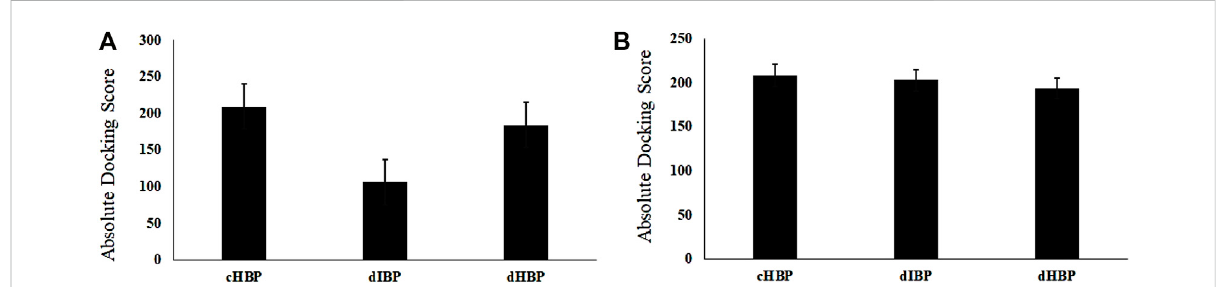
FIGURE 1 Graph of (A) integrin docking score; (B) HS docking score with designed peptides compared to positive control.